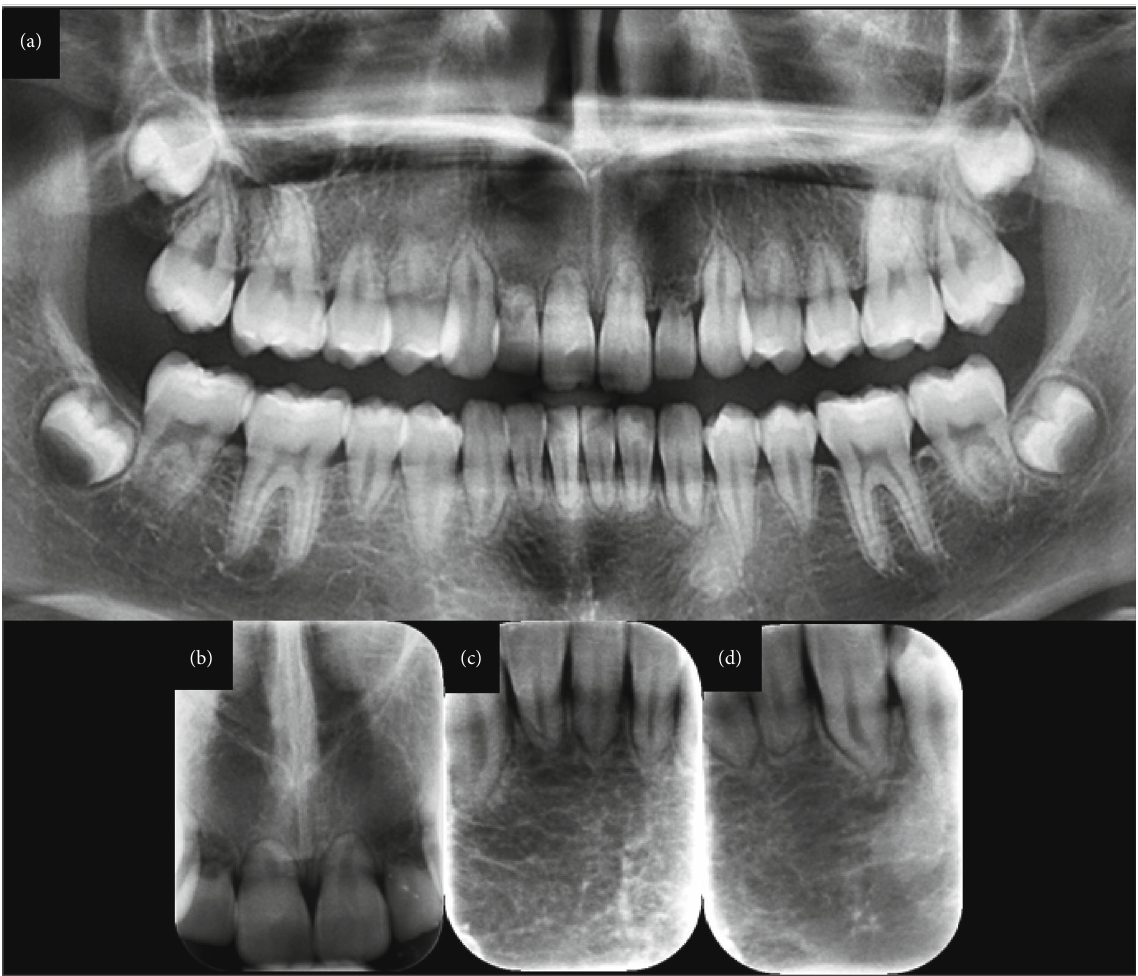
Figure 1: Initial radiographic examination of SRA (age of patient: 11 years and 9 months). (a) Panoramic radiography. (b) Periapical radiograph of the maxillary incisors. (c) and (d) Periapical radiographs of the lower incisors. Notice the abnormally short roots with round apices of all teeth except fi rst molars. Mandibular fi rst premolars also have short roots, but their root to crown ratio is bigger than